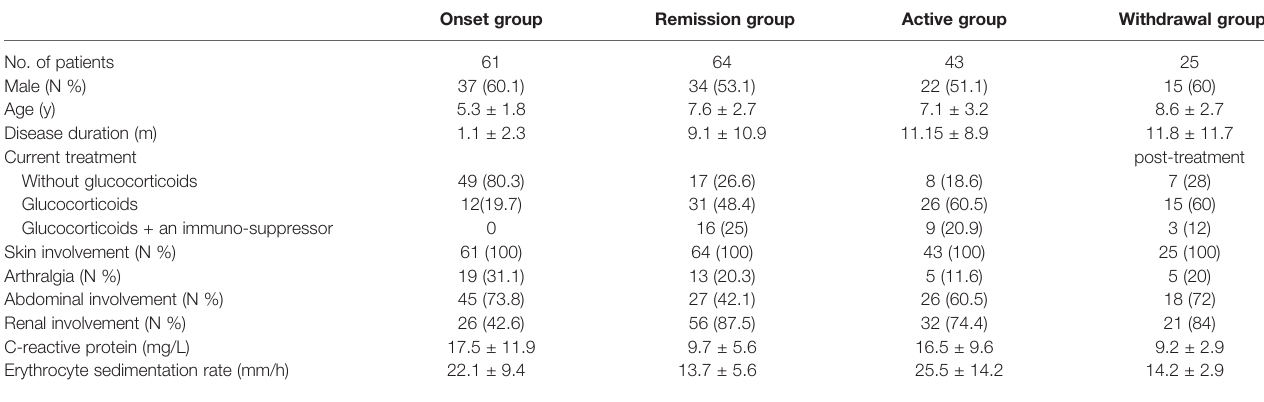
TABLE 1 | Clinical characteristics of the participants in this